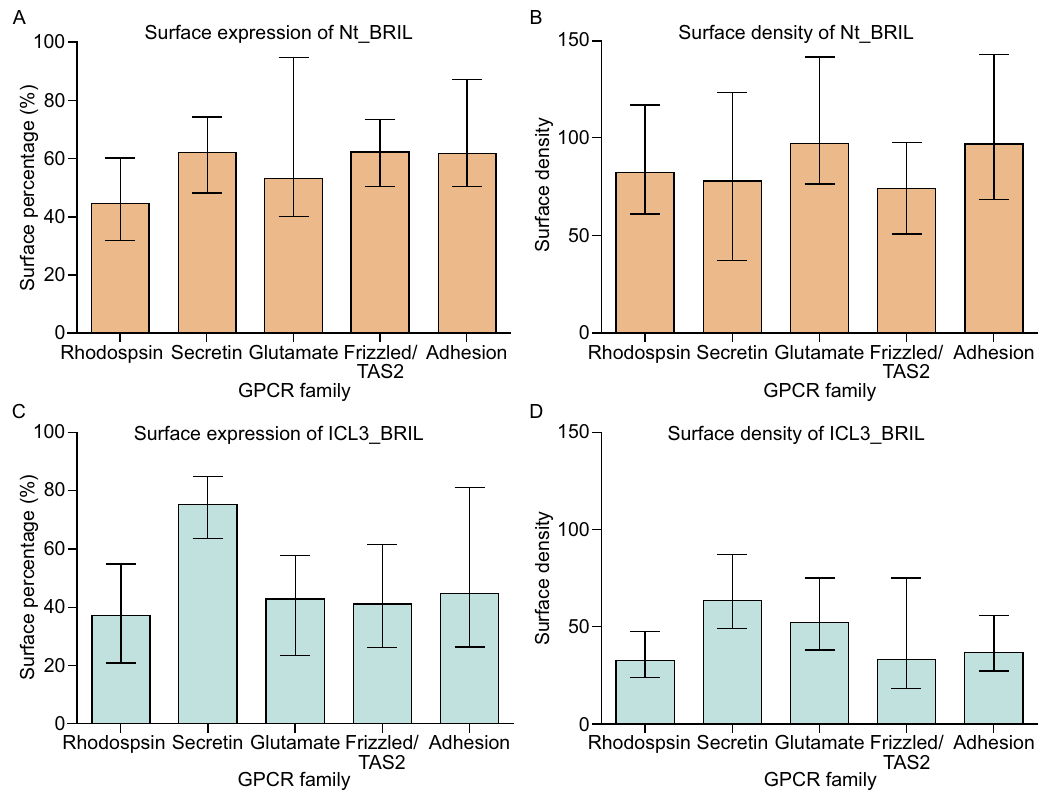
Figure 5. Surface expression by GPCR family. Distributions among GPCR families are shown for percentage of cells expressing GPCRs on their surface (A and C) and density of GPCRs on the surface (B and D) for Nt_BRIL (A and B) and ICL3_BRIL (C and D) constructs. Error bars indicate fi rst quartile from the median. Graphs are plotted as median values for the Rhodopsin, Secretin, Glutamate, Frizzled/Taste2, and Adhesion families with 719, 16, 22, 36, and 33 members, respectively. Error bars indicate fi rst quartile from